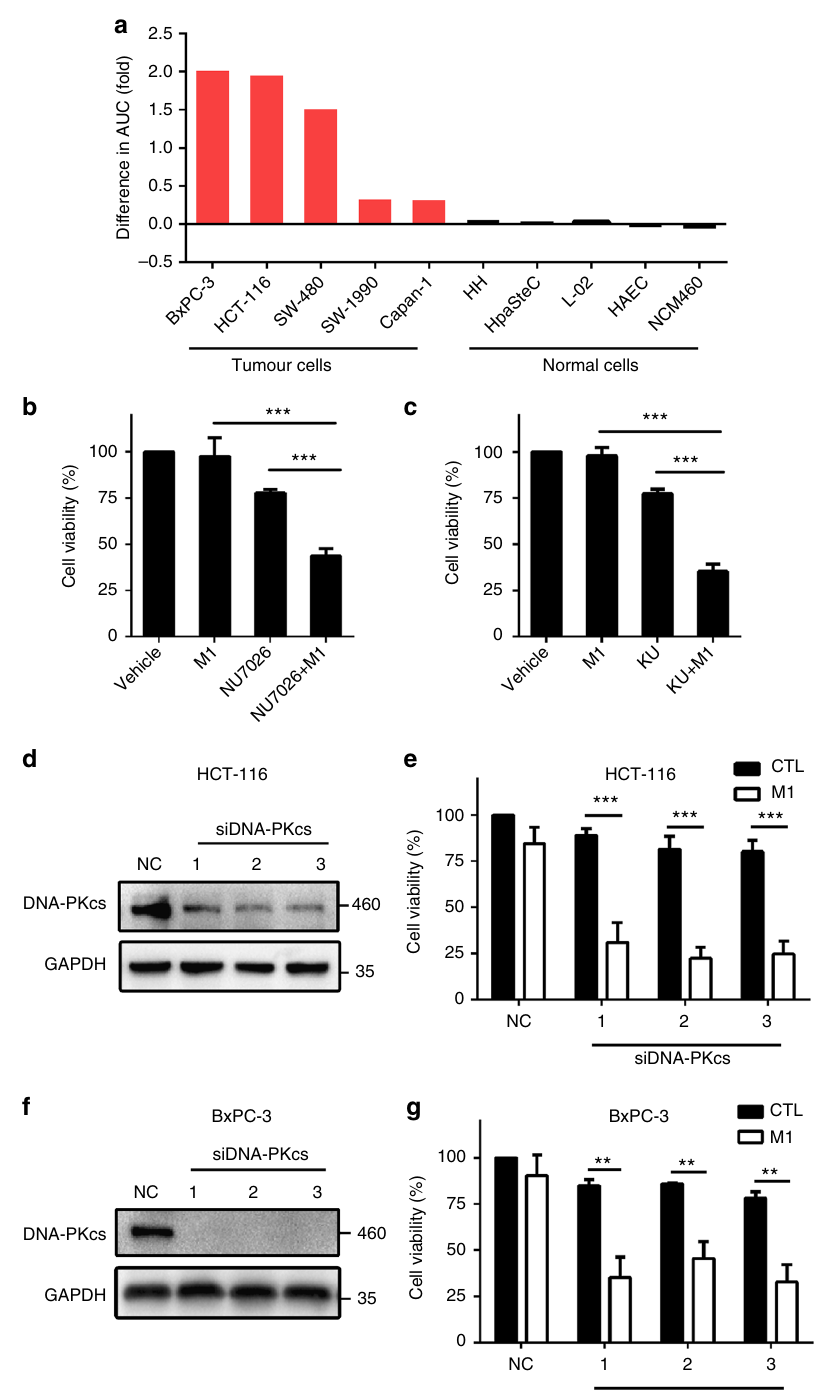
Fig. 2 DNA-PK inhibition enhances anticancer activity of OV M1. a Cells were incubated with increasing concentrations of NU7441 (0.5, 1, 2, 4, 8 μ M) in the absence or presence of M1 virus (MOI = 1), and the differences in the AUC (fold) between two dose – response curves for each cell line were calculated according to the formula (AUC Single – AUC Combined )/AUC Combined . b , c Relative cell viability in HCT-116 cells treated with vehicle, M1, DNA-PK